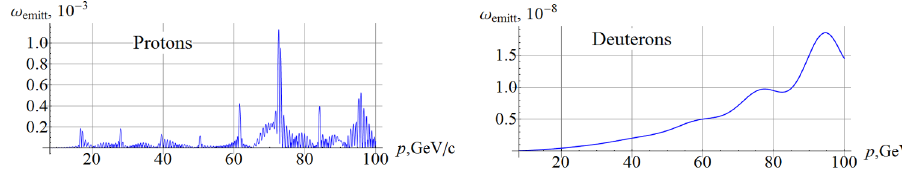
Figure 1. Coherent part of the resonance strength for protons and deuterons at the JLEIC